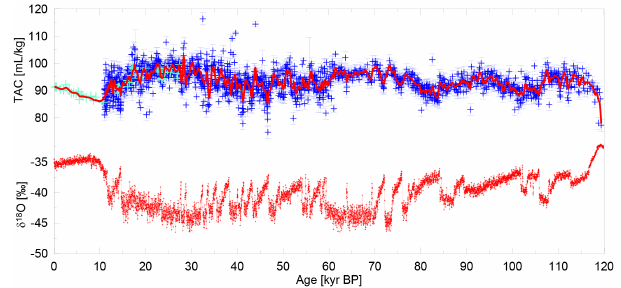
Figure 2. The NGRIP TAC record of this study on the AICC2012 gas age scale (Veres et al., 2013), using two different methods. Blue: the melt–refreeze data; turquoise: the vacuum-melt TAC. The red line represents a spline with a 750-year cutoff period, according to Enting (1987). At the bottom, the δ 18 O ice for the NGRIP ice core (NGRIP Project Members, 2004) is given.